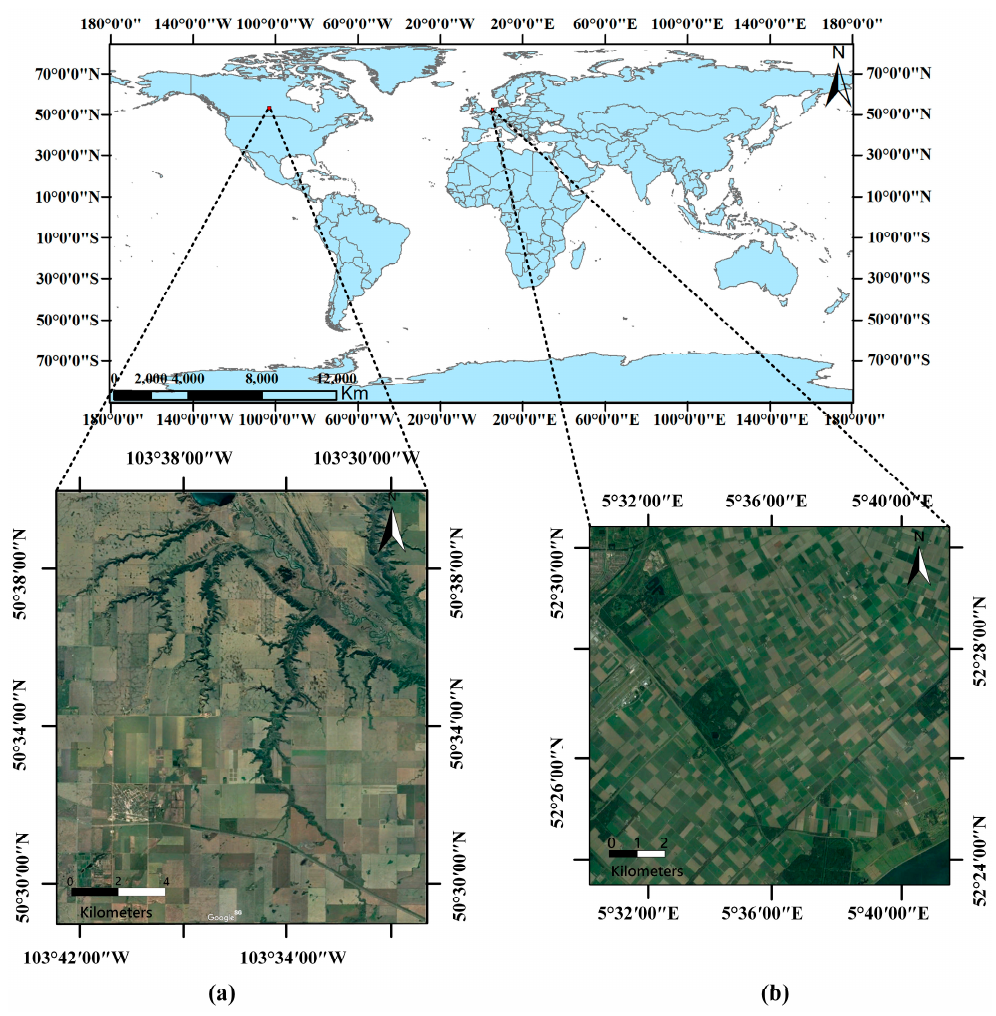
Figure 6. Location maps of the experimental sites from Google Earth: ( a ) Indian Head and ( b ) Flevoland.